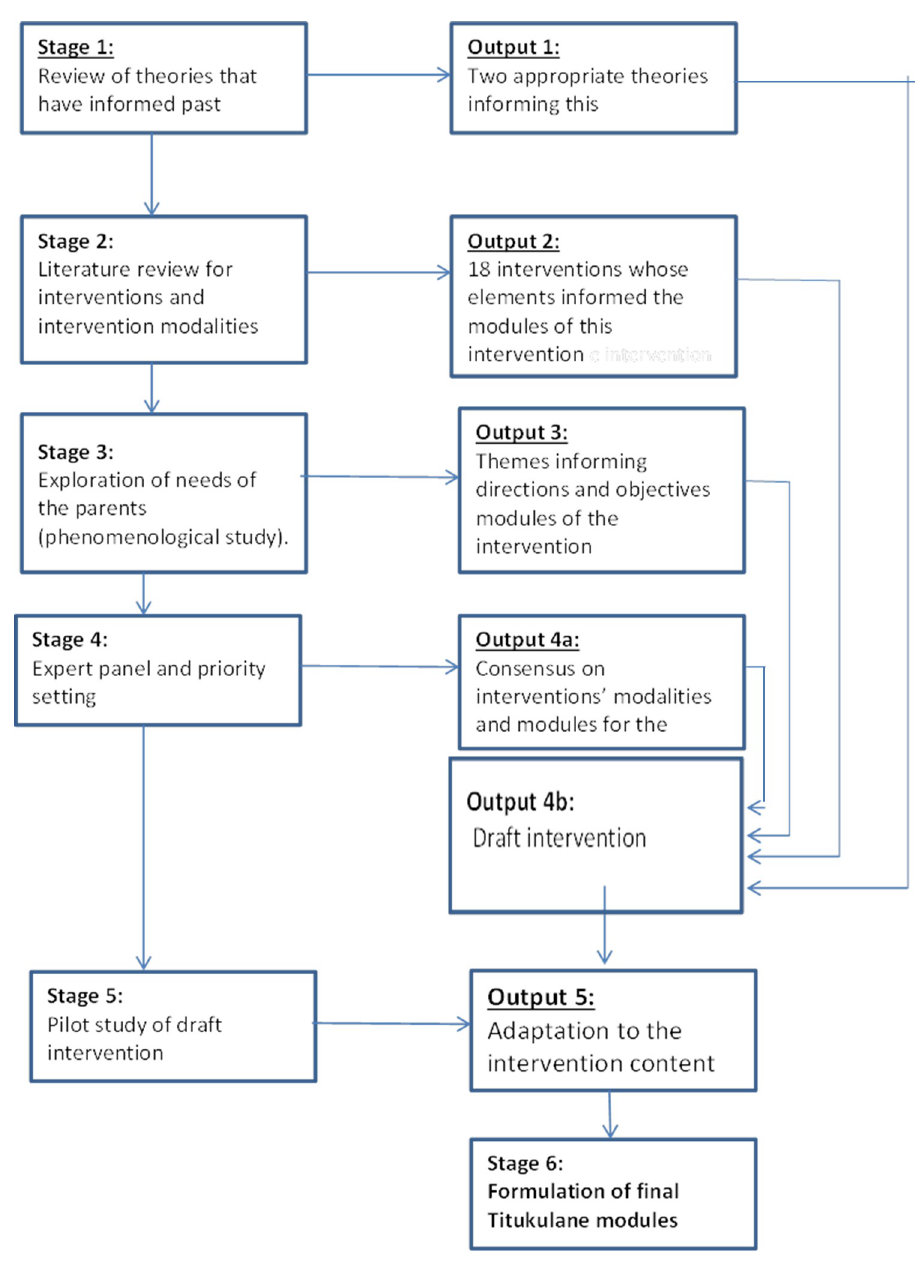
Fig 1. Titukulane intervention development process showing stages and output at each